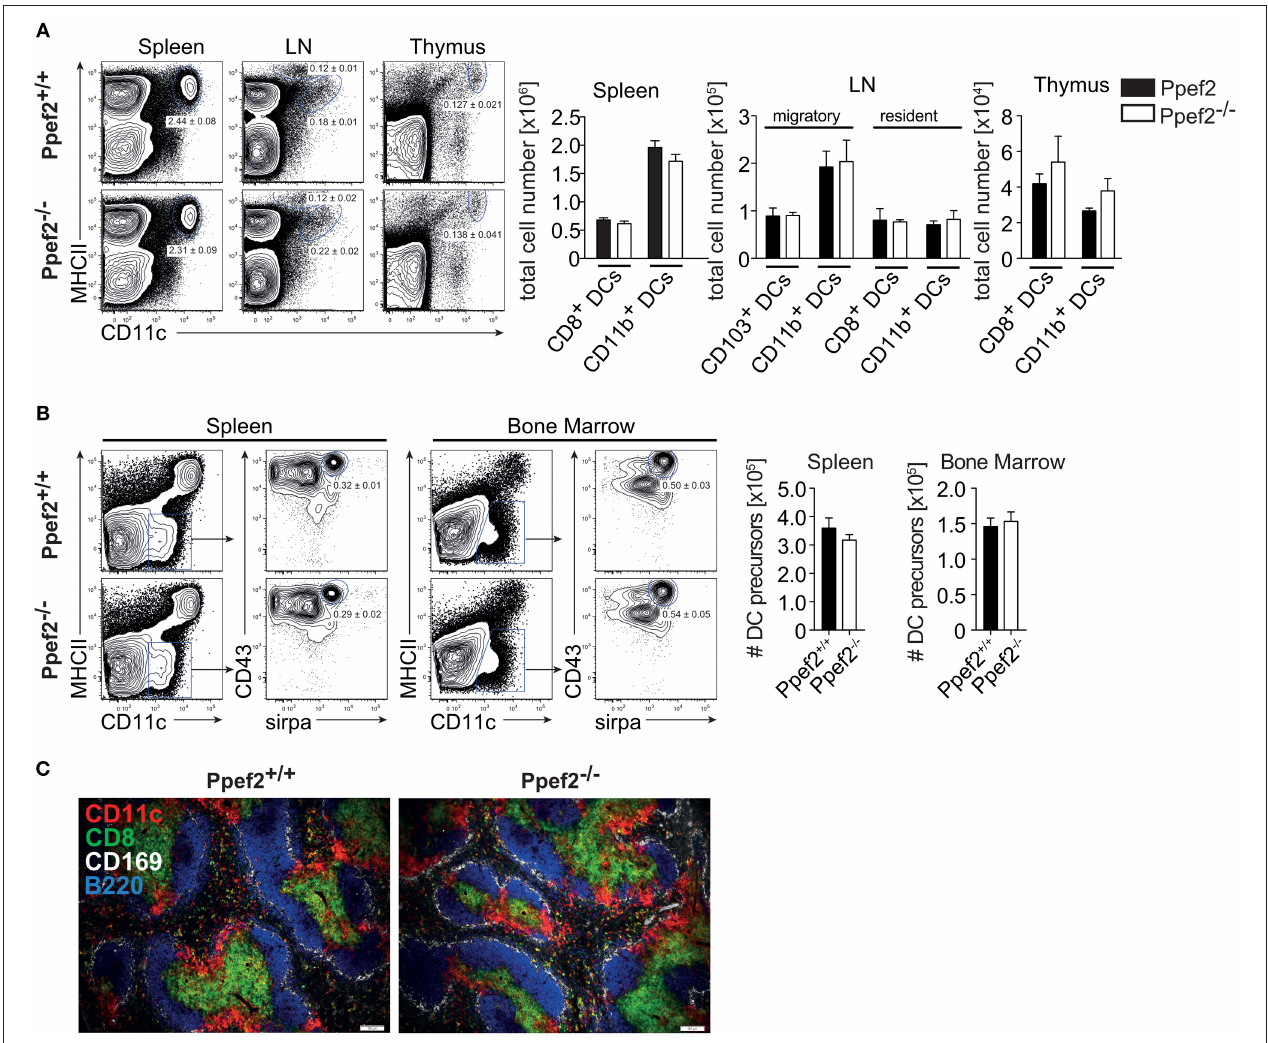
FIGURE 3 | Ppef2 − / − -mice have normal frequencies of DCs and DC-precursors. (A) DCs of spleen, LN and thymus were stained with CD11c and MHCII. Shown are representative FACS plots with the average DC percentages ± SEM of pooled data (spleen, 8 experiments ( n = 36); sLN, 4 experiments ( n = 23); thymus, 2 experiments ( n = 6) as well as the corresponding total cell numbers. (B) The frequency of DC precursors from spleen ( n = 3) and bone marrow ( n = 4). Shown is one representative experiment out of two with similar outcome. Statistical analysis of (A, B) was performed using Student’s t -test and all p -values were above 0.05. (C) Acetone fixed spleen sections of Ppef2 + / + and Ppef2 − / − mice were stained with antibodies against CD11c (red), CD8 (green), CD169 (white), and B220 (blue). Scale bars represent 100 µ m.